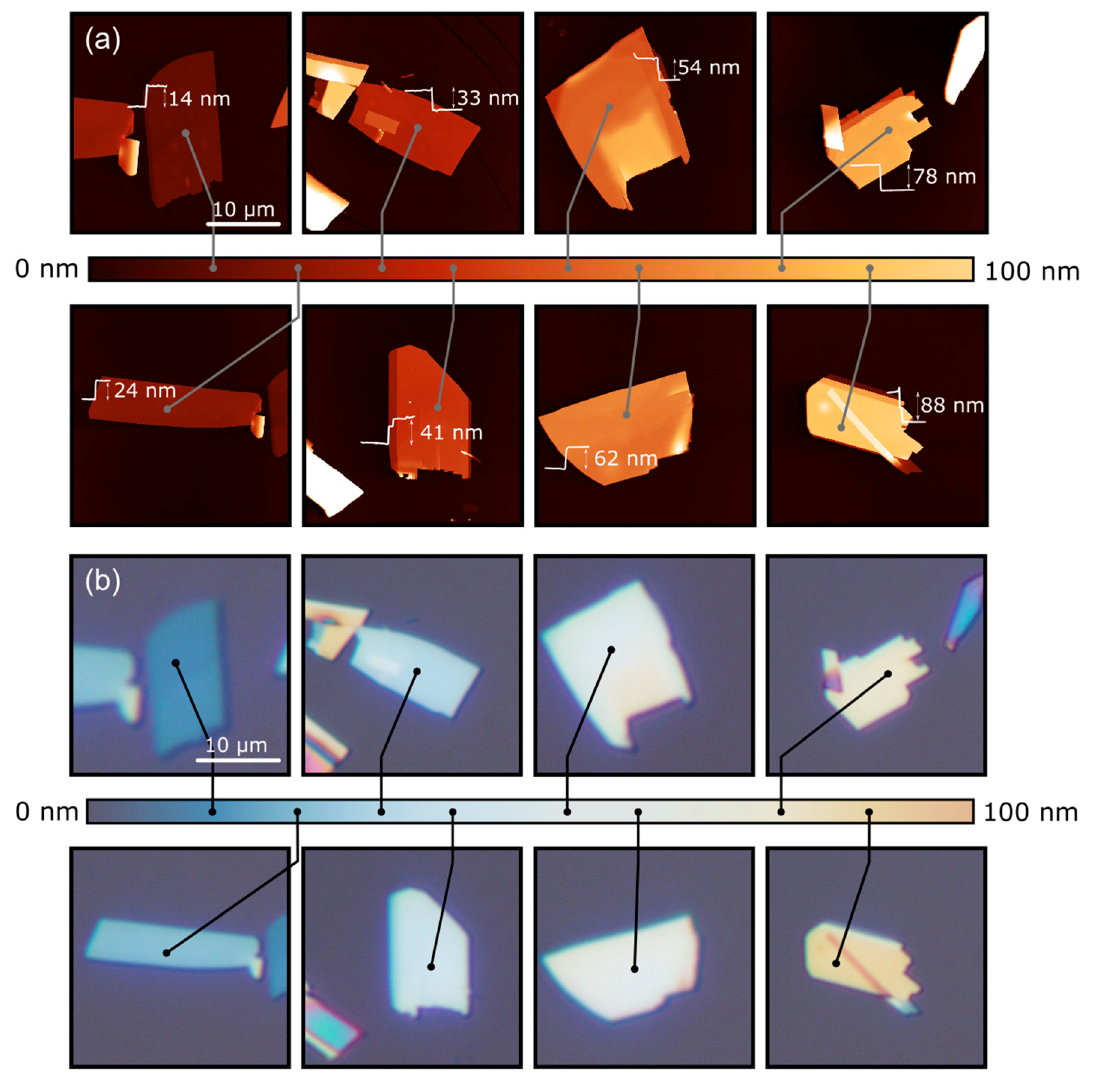
Figure 2. Thickness dependent apparent color of MoO 3 flakes. ( a ) AFM measurements of the exfoliated flakes with different thickness placed on an 88 nm SiO 2 /Si substrate. ( b ) Optical images of the flakes and a colorbar with the apparent color of flakes with thickness up to 88 nm. Scale bars: 10 µm.